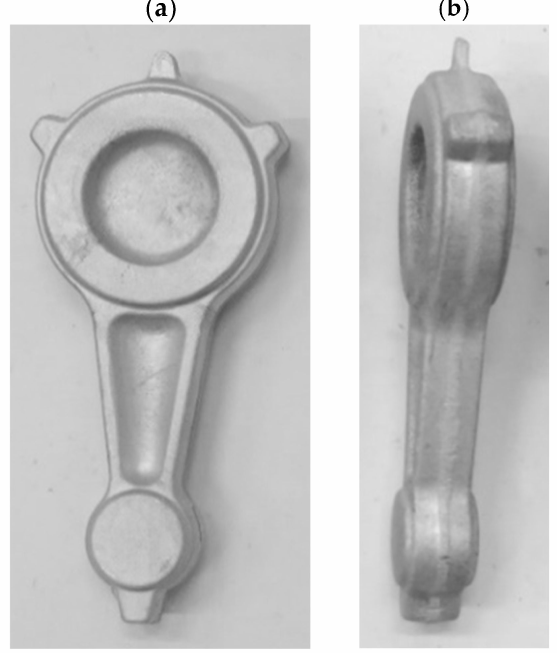
Figure 26. Connecting rod forgings made of AB-71100 aluminum alloy after flash trimming and etching, obtained from cast preforms in accordance with variant 2: ( a ) top view; ( b ) side view. The tests of the forging process performed on a crank press for the forging of connect- ing rods from preforms made of AB-71100 aluminum alloy in accordance with variant 1 made it possible to obtain defect-free products (Figures 27 and 28). The formed forgings were subjected to the process of trimming the flash and etching. The final forgings are shown in Figure 28.